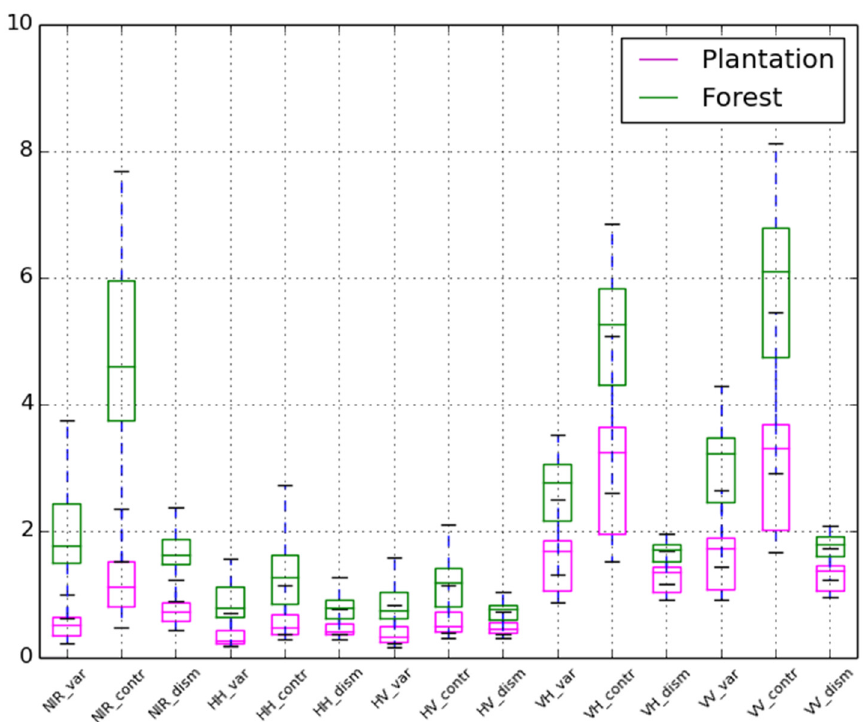
Figure 6. Box and whisker plot showing distributions for plantation and forest for Landsat-8 NIR, PALSAR-2 HH and HV, and Sentinel-1 VV and VH for texture metrics.